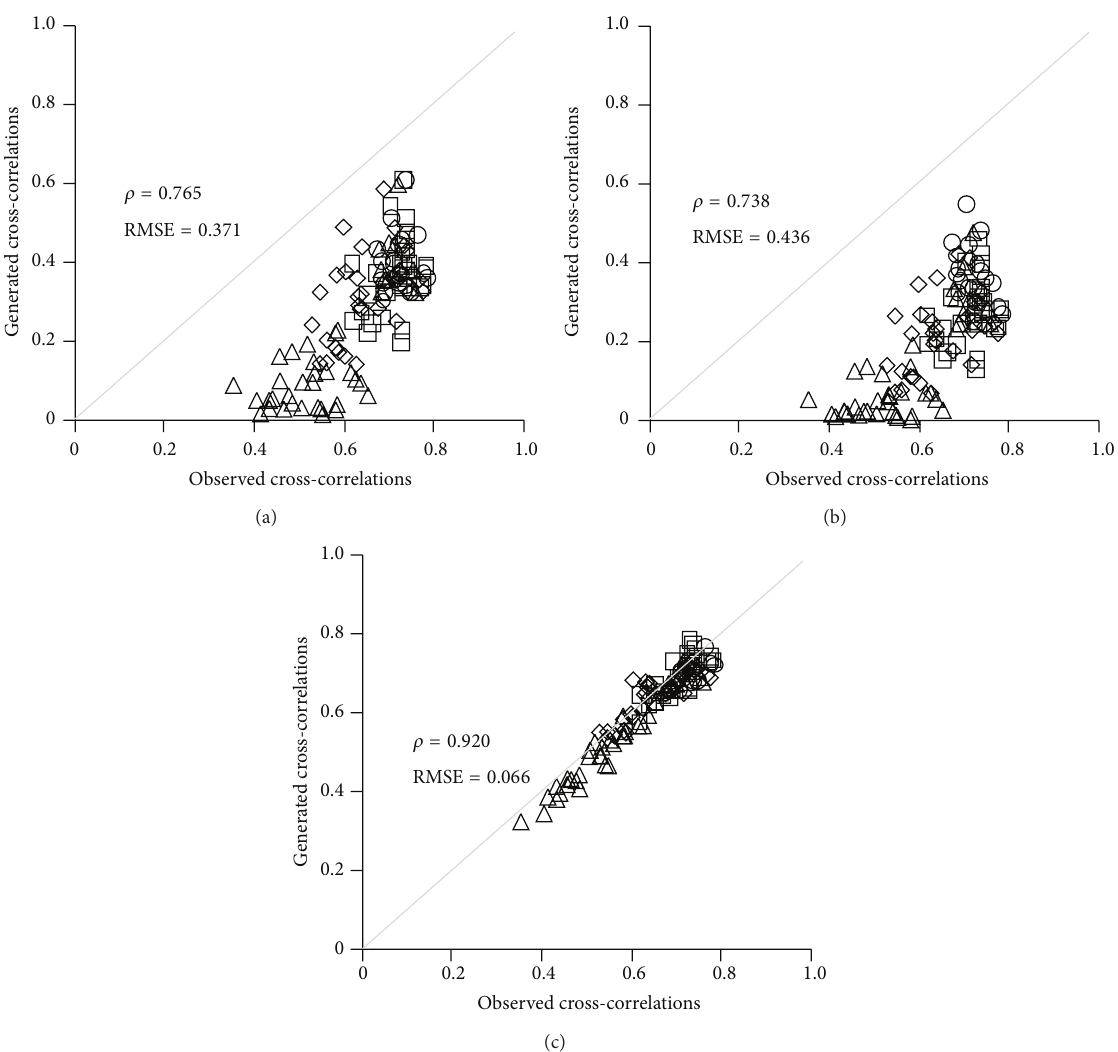
Figure 5: Comparison between observed and generated cross-correlations between daily maximum and minimum temperatures for all weather stations and for each month. (a) First model, (b) second model, and (c) third model. ( I ) December-January-February, ( ◻ )